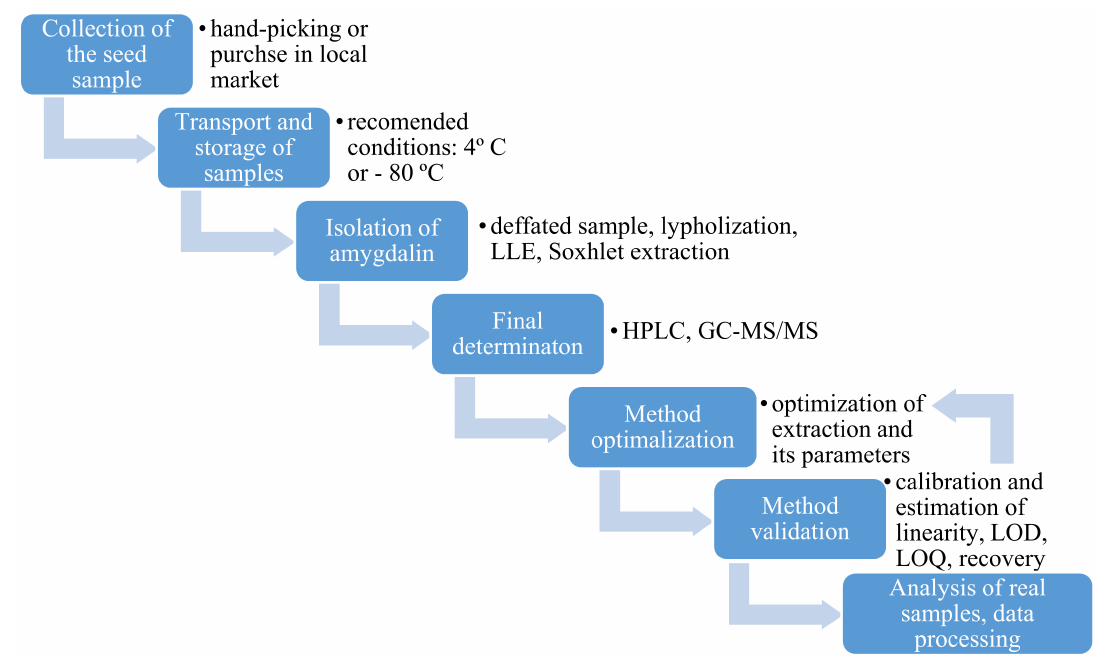
Figure 5. General workflow during the analysis of seed